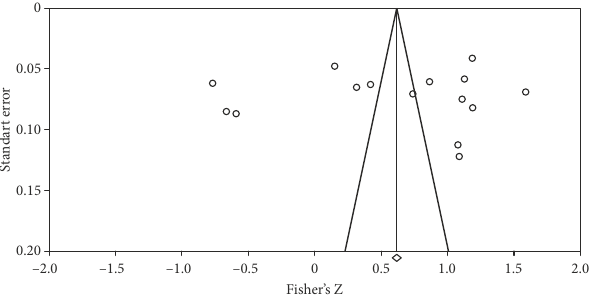
Figure 2. Funnel plot of duration-engineering harmony effect value